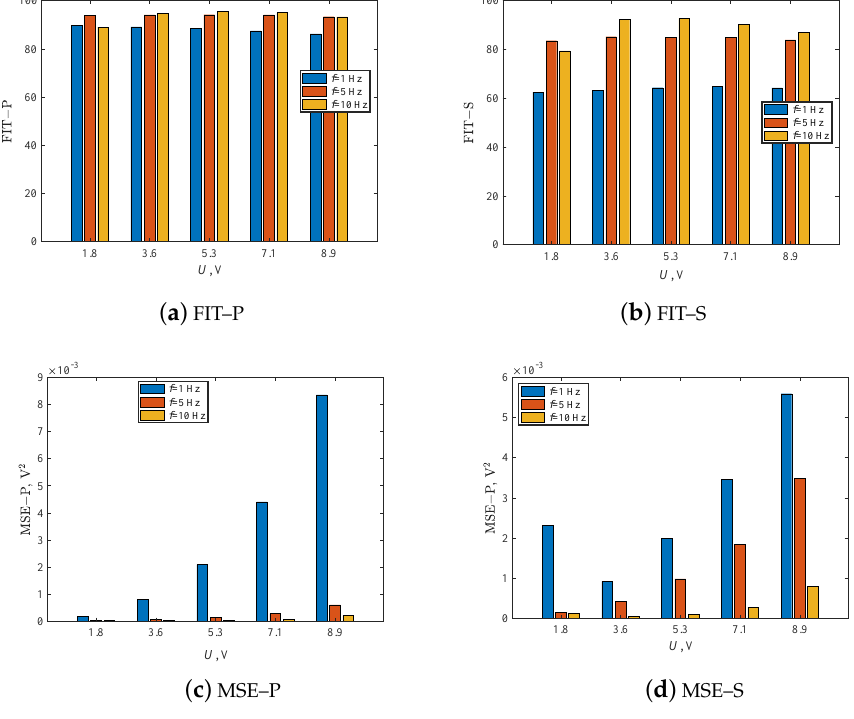
Figure 9. Quality metrics vs. voltage